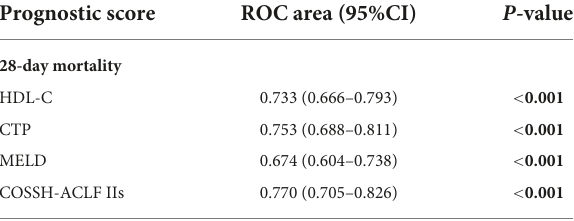
TABLE 4 The performance of high-density lipoprotein cholesterol (HDL-C) and the prognostic scores for predicting outcome at 28 days.